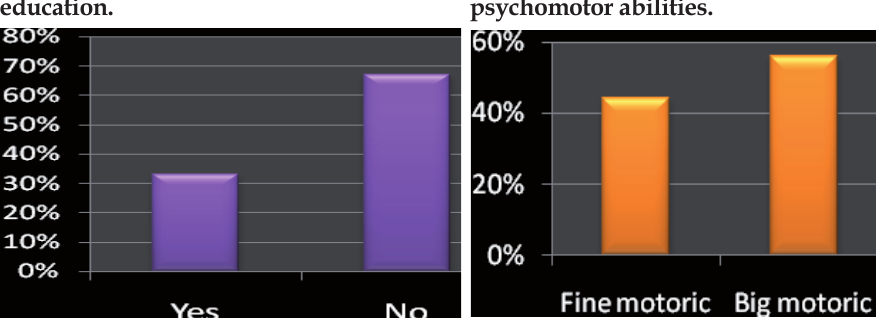
Fig. 2.3. Trainings regarding psychomotor Fig. 2.4. Typical elements of developed education. psychomotor